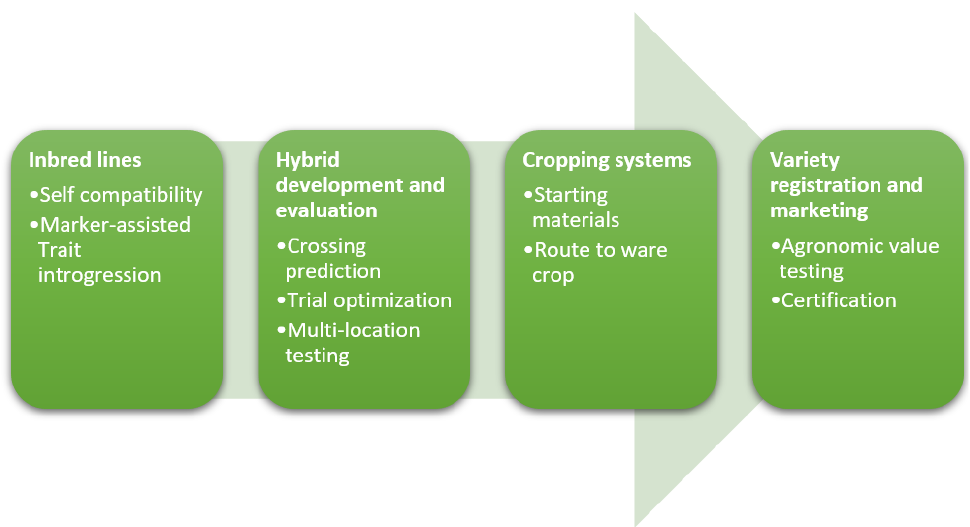
Figure 1. Main components of a hybrid breeding potato breeding program. From development of inbred lines to the release of a commercial product. In the first step inbred lines are developed, then hybrids are created, to arrive at a markable hybrid. These products are registered as